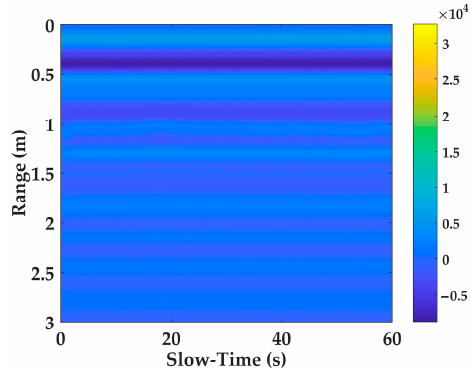
Figure 2. Raw echo data D ( m , n ) when the human target is 2.5 m behind the wall.